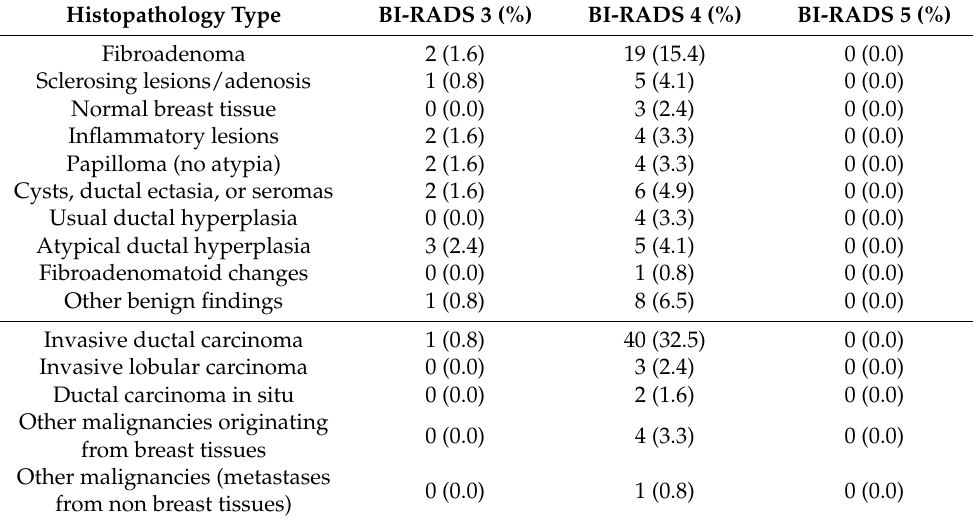
Table 6. Ensemble of support vector machines: BI-RADS diagnostic categories predicted for breast masses of the Testing set I according to histopathology groups.